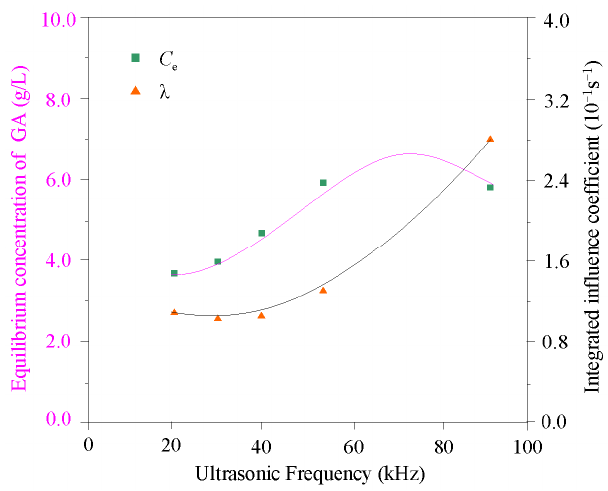
Figure 7. The equilibrium concentration ( C e ) of glycyrrhizic acid, and integrated influence coefficient ( λ ) with different ultrasonic frequencies.